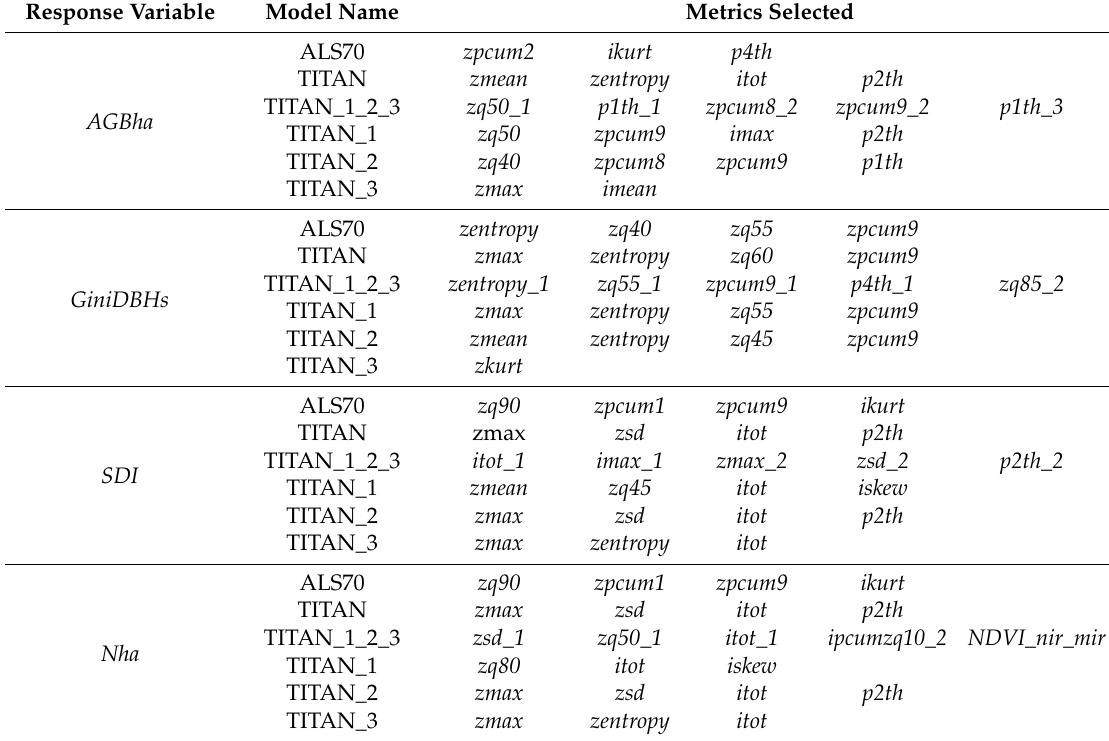
Table 4. Metrics selected in each set of metrics and for each response